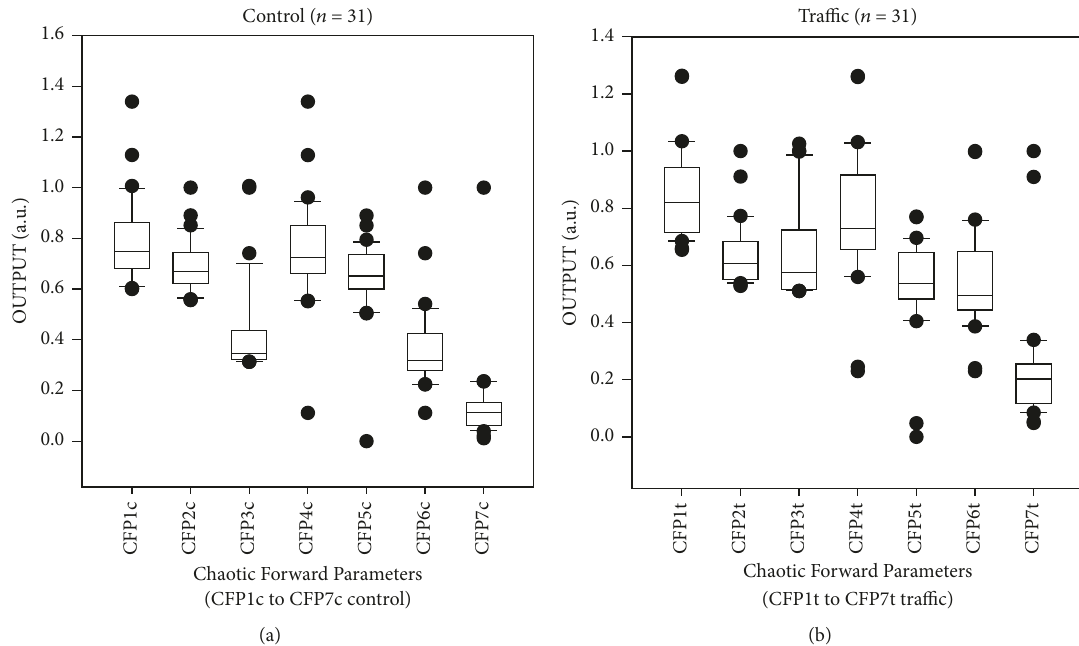
Figure 5: The boxplots illustrate the values of chaotic forward parameters one to seven (CFP1 to CFP7) for control (a) and traffic noise exposure (b) subjects with 500 RR intervals throughout. The point closest to the zero is the minimum and the point farthest away is the maximum. The boundary of the box closest to zero indicates the 25th percentile, a line within the box marks the median (not the mean), and the boundary of the box farthest from zero indicates the 75th percentile. The difference between these points is the interquartile range (IQR). Whiskers (or error bars) above and below the box indicate the 90th and 10th percentiles, respectively.